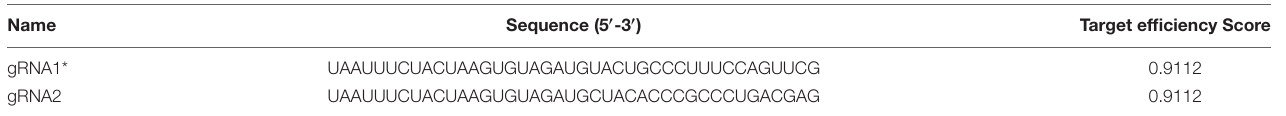
TABLE 2 | The Sequences and the corresponding targeting efficiency scores of the gRNAs used in this